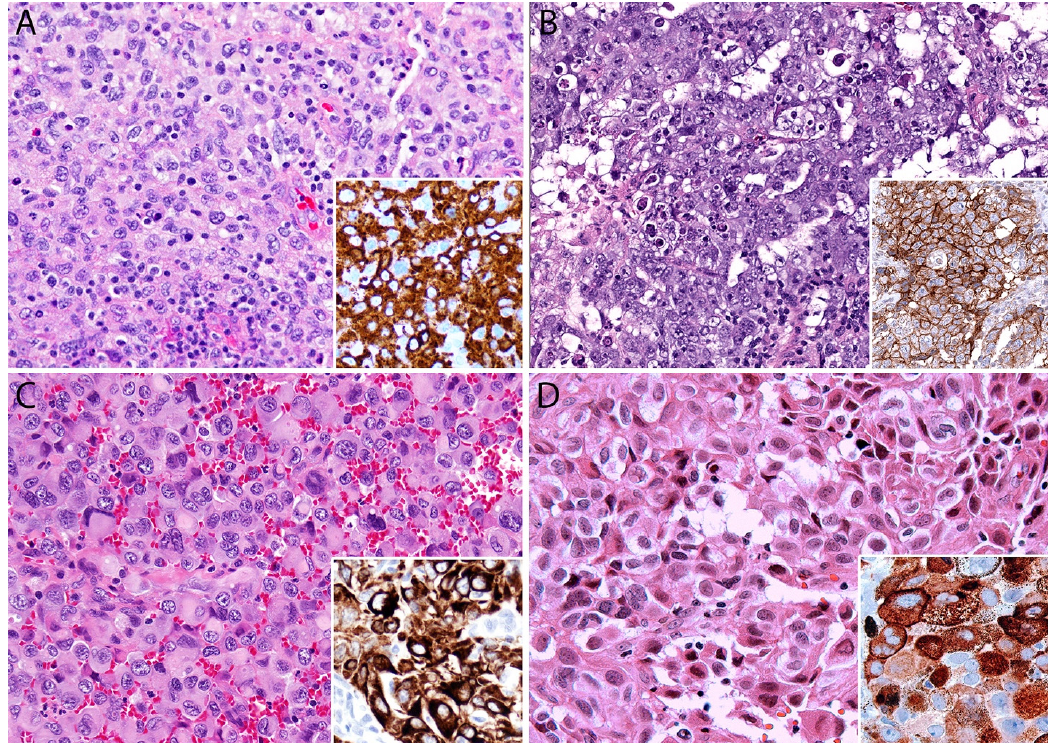
Figure 7. Differential diagnosis of systemic ALK- ALCL. ( A ) Histiocytic sarcoma resembling ALCL. The tumor cells are positive for CD163 (inset), and negative for CD30 or T-cell markers (not shown in Figure). ( B ) Embryonal carcinoma with solid and pseudoglandular patterns. Note the deeply basophilic cytoplasm, anaplastic features, and abundant apoptosis. The tumor is strongly positive for CD30 (inset), cytokeratin, and OCT3/4 (not shown in Figure). ( C ) Epithelioid sarcoma mimicking ALCL. The tumor is positive for cytokeratin (inset) and ERG, while negative for INI1 (not shown in Figure). ( D ) Epithelioid melanoma metastatic to a lymph node. The neoplastic cells are positive for Melan-A (inset).